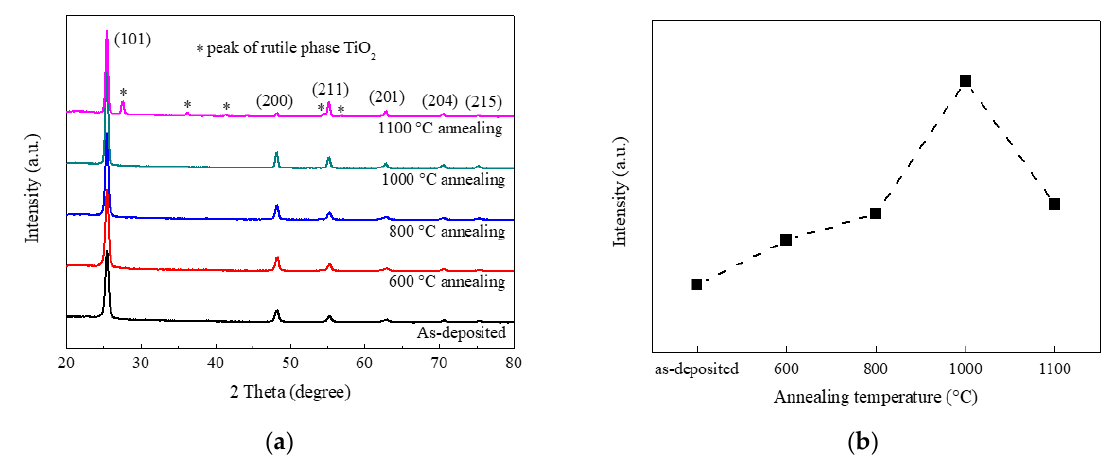
Figure 1. GIXRD results of as-deposited TiO 2 films and TiO 2 films after annealing. (( a ) GIXRD patterns of TiO 2 films; ( b ) (101) peak intensities of TiO 2 films).